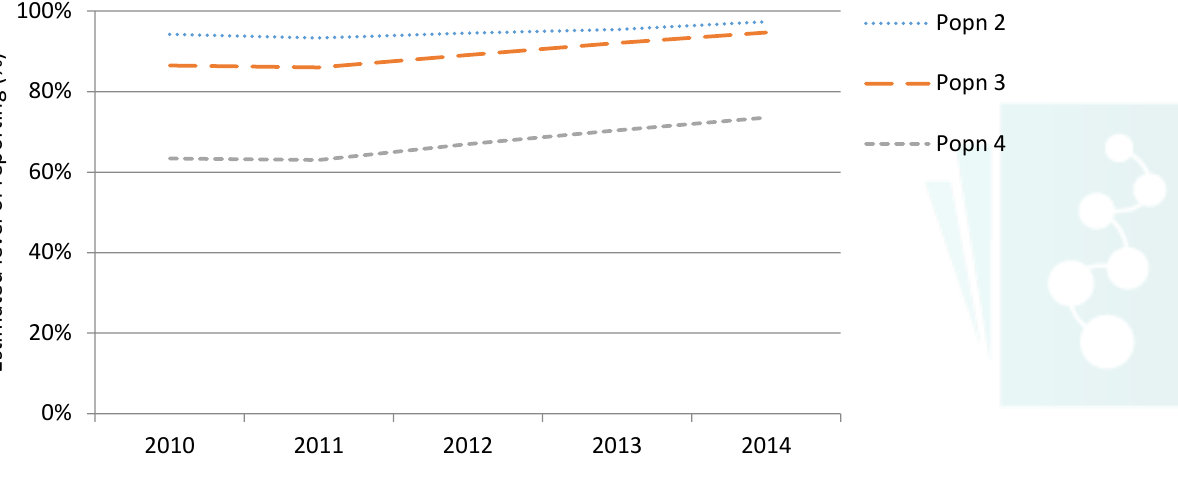
Figure 8: Estimated level of reporting of Aboriginal mothers on the birth data in 2010 to 2014 according to different methods of enhanced reporting of